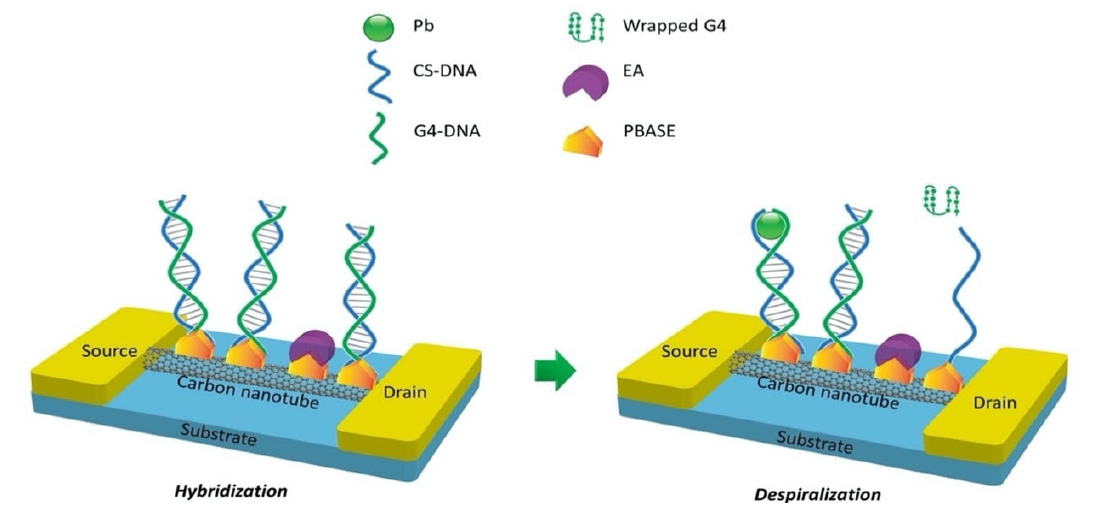
Figure 7. Hybridization and despiralization of G4 ‐ DNA and CS ‐ DNA induced conductivity of CNT ‐ FET sensor.